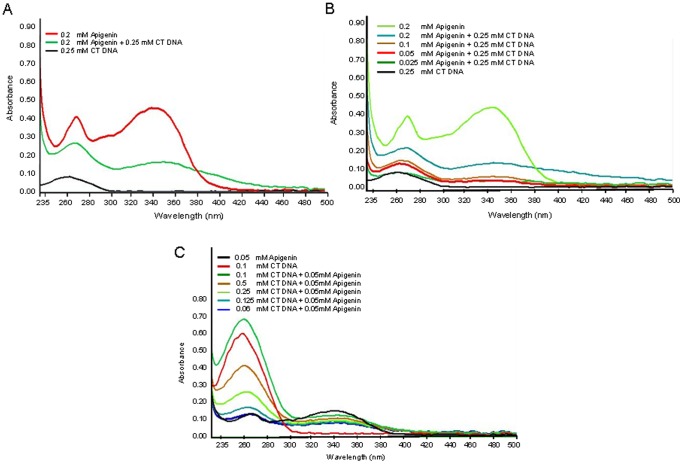
Interaction of apigenin with calf thymus (CT) DNA.(A) UV-Vis spectra of CT-DNA, apigenin and apigenin+CT-DNA. (B) UV-Vis spectra of CT-DNA with varying concentration of apigenin ranging from 0.025 mM to 0.2 mM in solution. (C) UV-Vis spectra with 0.05 mM apigenin along with varying concentration of CT-DNA ranging from 0.06 mM to 0.1 mM in solution. Absorption spectra of solution were recorded from 230 nm to 500 nm using Nanodrop. The experiment was repeated three times with similar results. Details are described in materials and methods section.